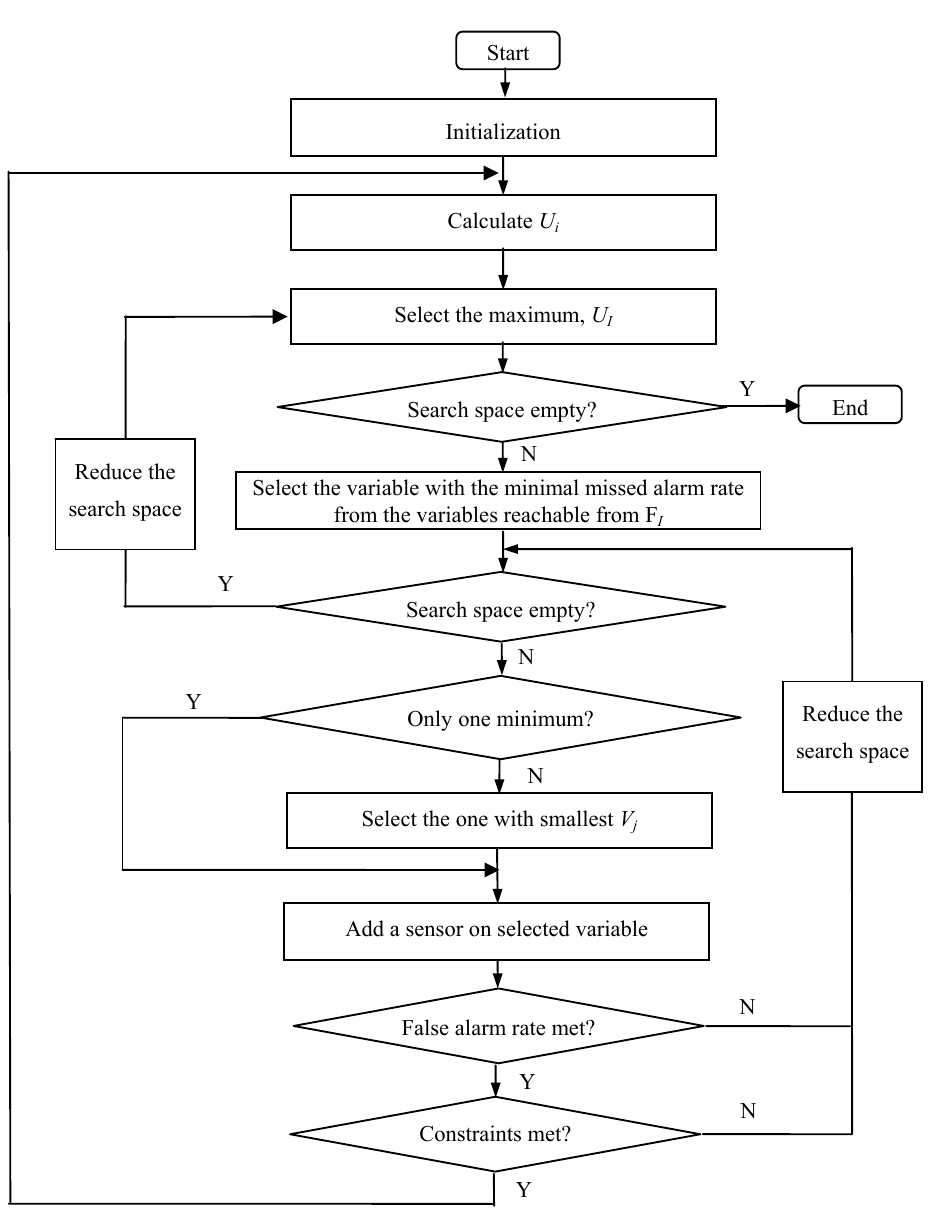
Figure 3. Flow chart of the optimization